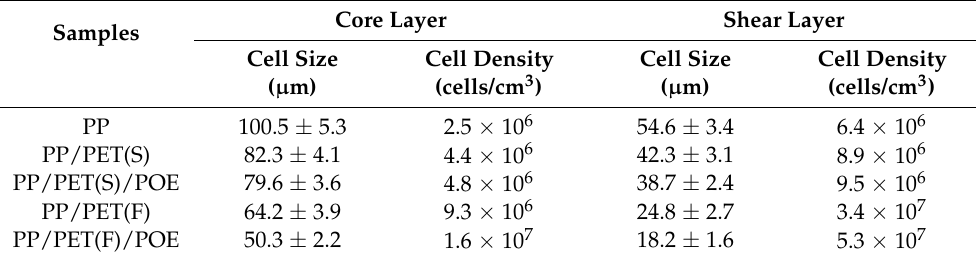
Table 3. Statistical results of cell size and cell density at different layers in all foams.